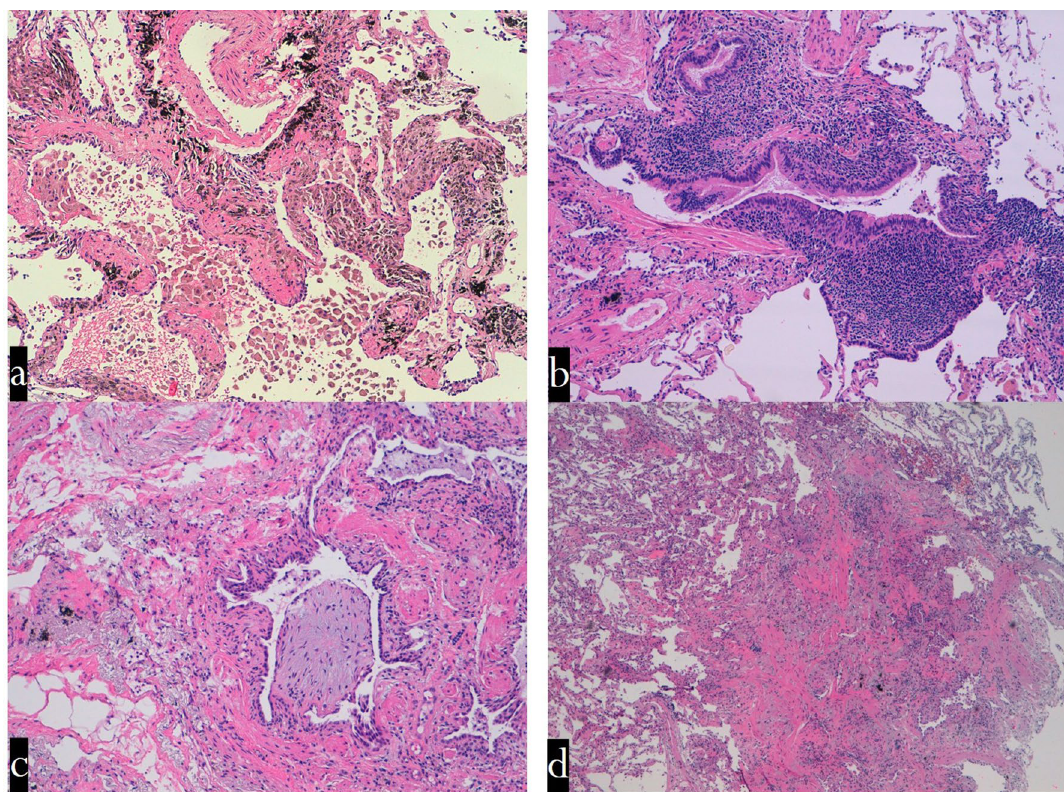
Figure 3. Transbronchial cryobiopsy. Histological findings (haematoxylin–eosin staining: mid power). ( a ) Respiratory bronchiolitis: a smoker’s macrophages in the lumen of the respiratory bronchiole and surrounding alveoli. The wall of the respiratory bronchiole is thickened by collagen deposition. ( b ) Follicular bronchiolitis: lymphoid follicles are evident in the wall of a terminal bronchiole. The lumen of this airway is partly occluded. ( c ) ILD with prominent bronchiolar involvement: The lumen of a terminal bronchiole is almost completely occluded by a polyp made up mainly of loose connective tissue (bronchiolitis in HP). ( d ) Constrictive bronchiolitis: a terminal bronchiole is completely substituted by a scar. * HPE histopathological examination, GL ILD granulomatous lymphocytic interstitial lung disease, CVID common variable immunodeficiency, GGO ground-glass opacity, NSIP nonspecific interstitial pneumonia, ILD interstitial lung disease, ANCA—anti- neutrophilic cytoplasmic antibody, OP organizing pneumonia, COPD chronic obstructive pulmonary disease, MAC—mycobacterium avium complex, HP hypersensitivity pneumonitis, DIPNECH diffuse idiopathic pulmonary neuroendocrine cell hyperplasia, CT computed tomography, DIP desquamative interstitial pneumonia, ILD smoking-related interstitial lung